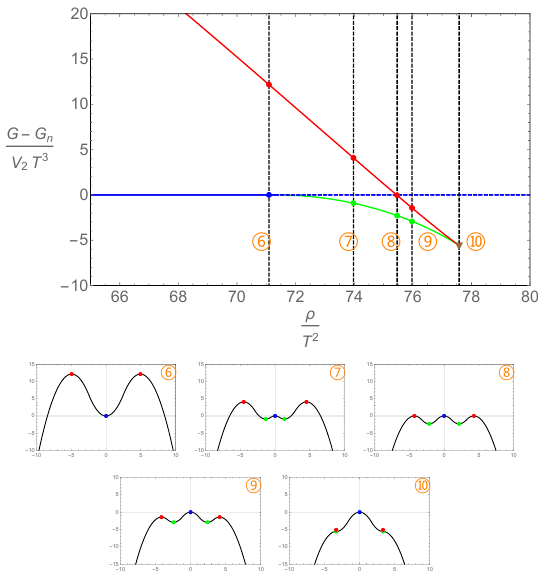
Figure 8 . The potential landscape the 0th order phase transitions. The shapes of the potential indicated with – – (cid:181) relate to the corresponding points in the top panel. Same colors are also used.